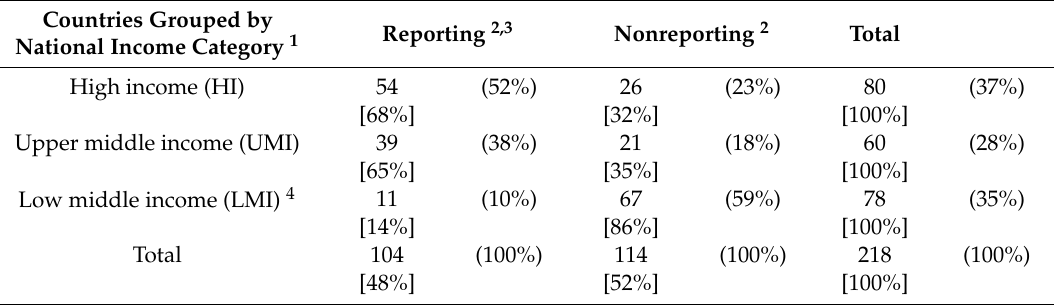
Table 2. Status of countries’ reporting of mesothelioma deaths to the WHO by national income category 1 .